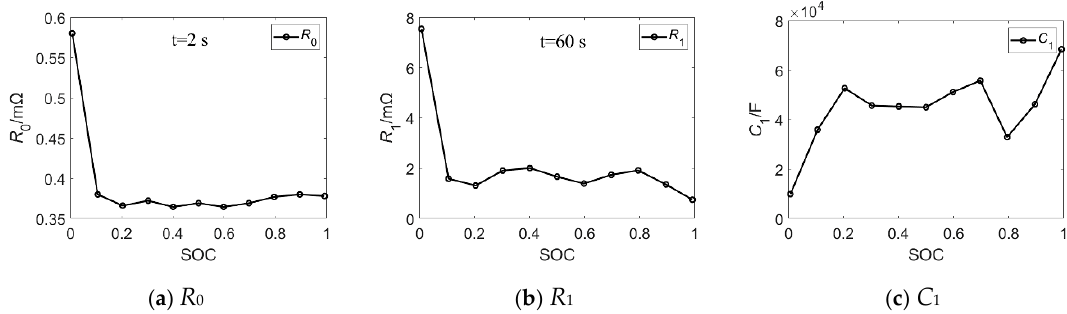
Figure 4. Model parameters of the battery module as a function of SOC.